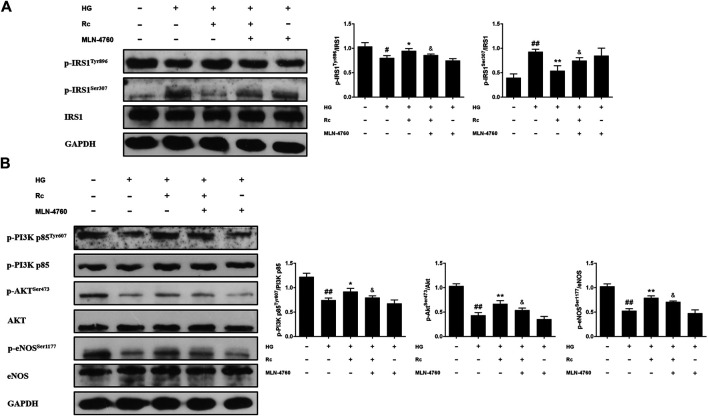
Effects of ginsenoside Rc with MLN-4760 on the insulin signaling pathway in HUVECs. The cells were treated with HG plus ginsenoside Rc (50 μM) with or without MLN-4760 (100 nM) for 24 h followed by insulin (100 nM) stimulation for 30 min. (A) Western blot analysis for p-IRS1Tyr896 and p-IRS1ser307. (B) Western blot analysis for p-PI3K p85Tyr607, p-AktSer473, and p-eNOSSer1177. Data were expressed as mean ± SD from three independent experiments. #
p < 0.05 and ##
p < 0.01 compared with control, *
p < 0.05 and **
p < 0.01 compared with HG, and &
p < 0.05 compared with HG + ginsenoside Rc.